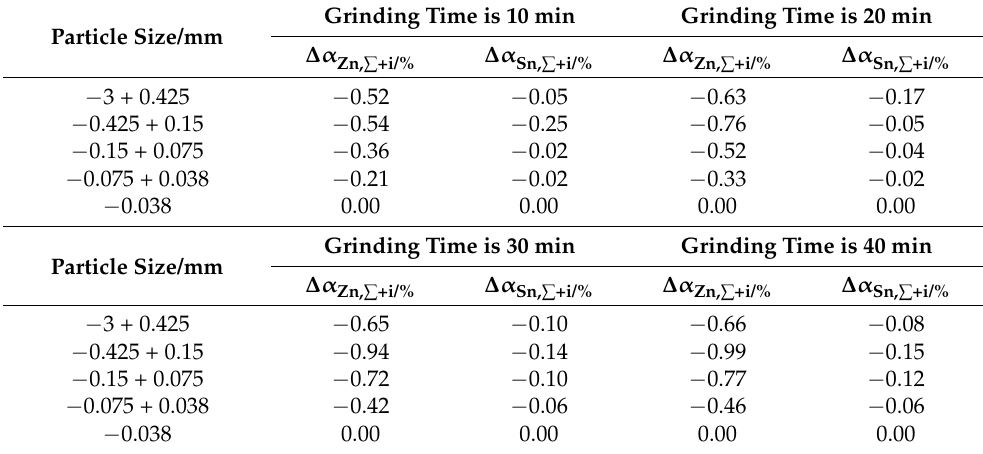
Table 8. Changes in the cumulative grade for different grinding times when the mill speed is 12.8 r/min.